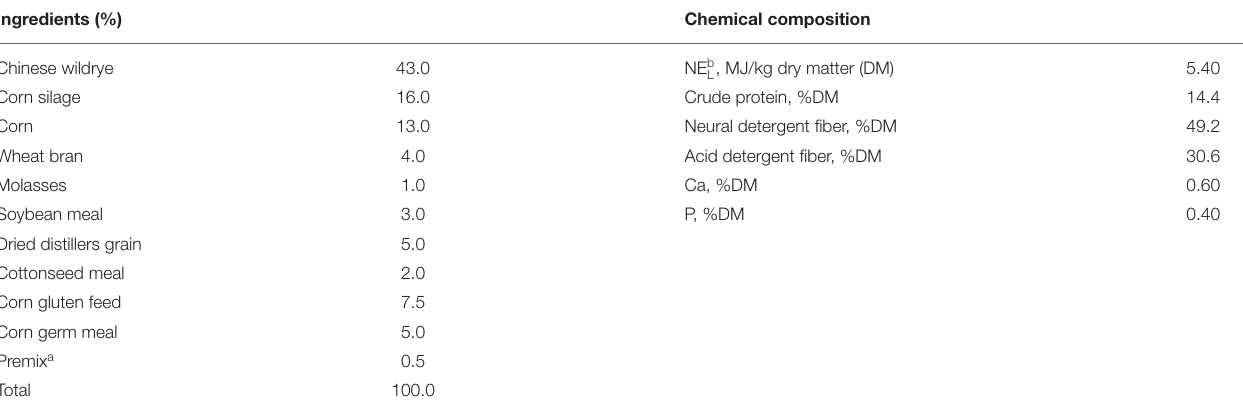
TABLE 1 | Ingredients and chemical compositions of diets for donor